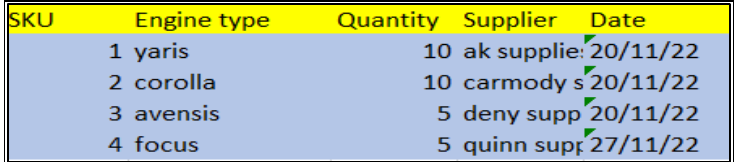
Fig 8b. Copied data from the stock and inventory screen